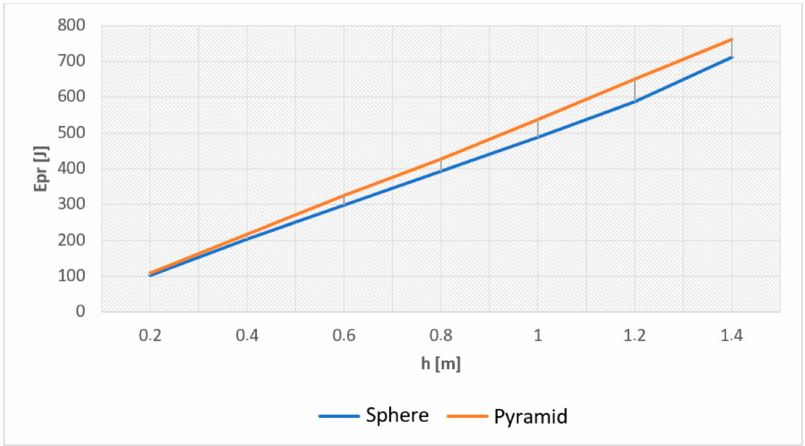
Figure 8. A comparison of the correlation between the impact energy E Pr and the impact height h for the impactor types used.